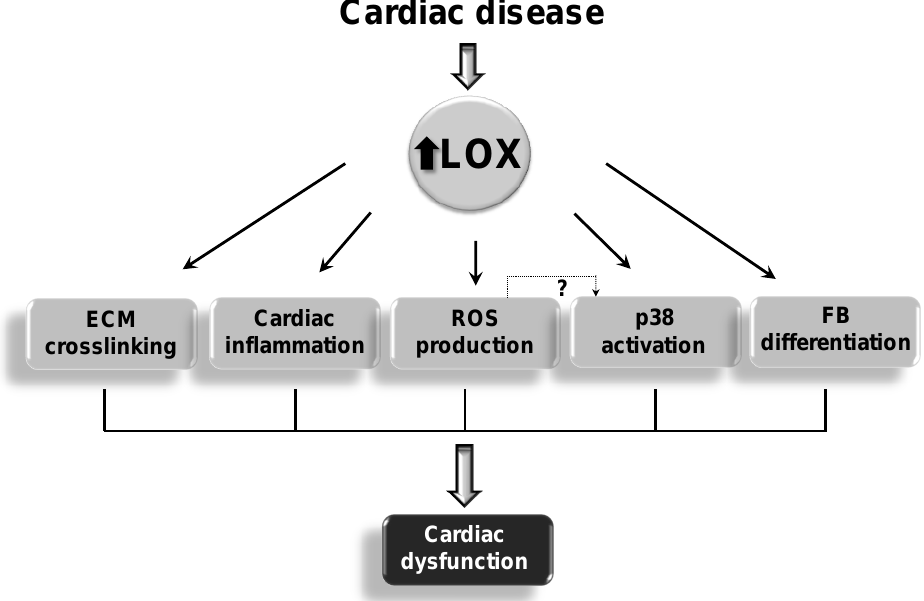
Figure 7. The upregulation of LOX/LOXLs in cardiac diseases affects several processes that contribute to cardiac dysfunction. ECM: extracellular matrix; FB: fibroblast; ROS: reactive oxygen species. Similarly, Ang II-induced cardiac hypertrophy was exacerbated in transgenic mice that overexpress LOXL1 specifically in cardiomyocytes, which exhibited myocyte hypertrophy, and higher mRNA levels of brain natriuretic peptide (Bnp) than their WT littermates. Echocardiographic